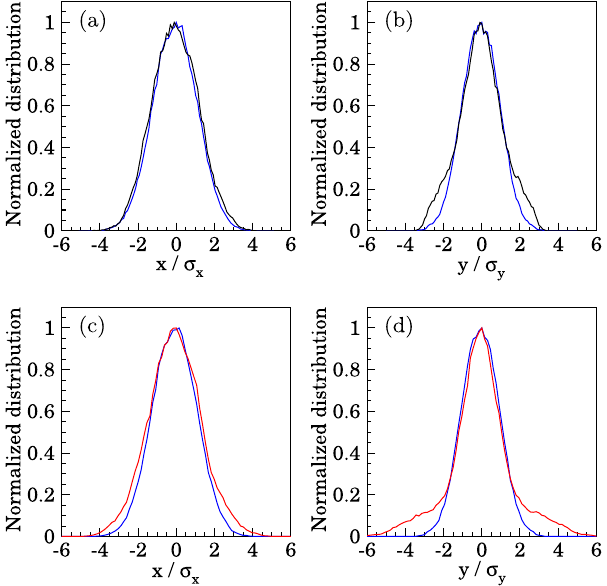
8. Pictures (a) and (b) show the horizontal and vertical beam profiles in simulations with the chromaticity set to zero. The working point is Q x 0 ¼ 6 . 104 ; Q y 0 ¼ 6 . 476 . The blue curves are the initial profiles while the black curves are the final profiles. Pictures (c) and (d) represent the same settings, but including the chromatic effect. These beam distributions are computed at the location of the vertical wire scanner. In this case the final profiles are shown in